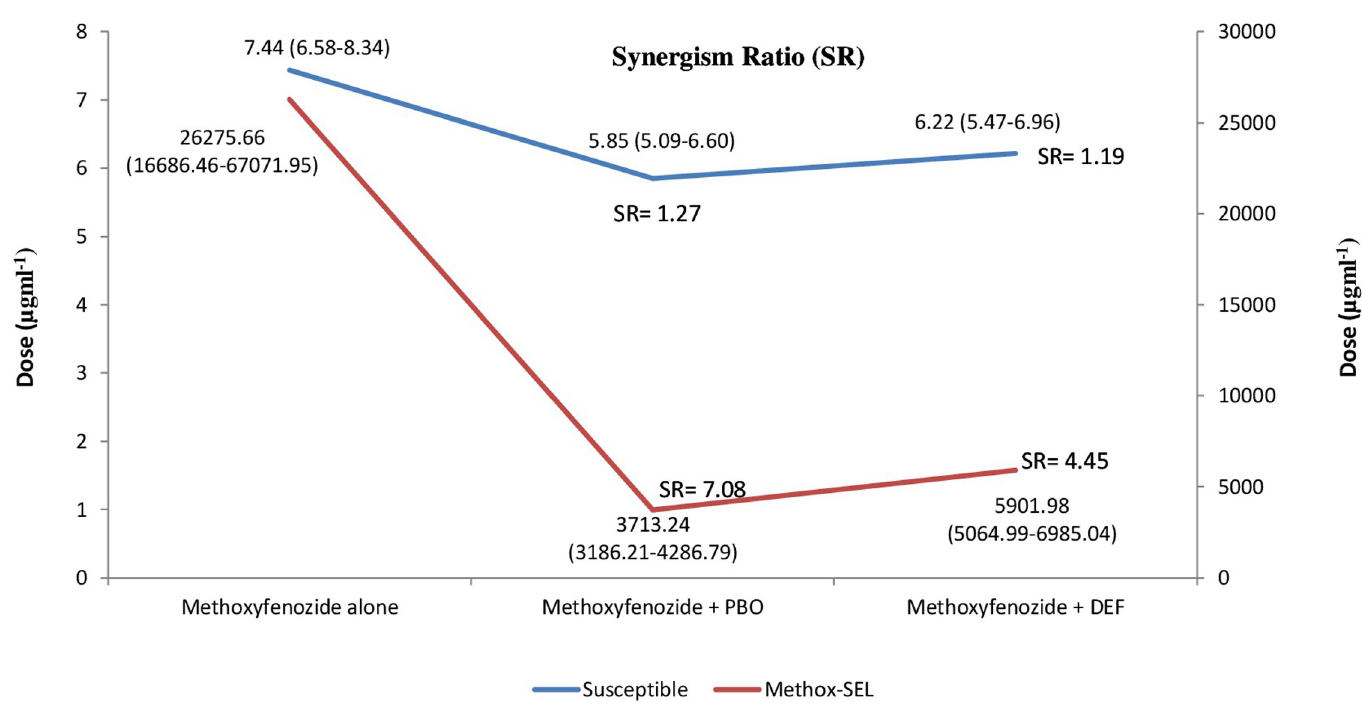
Fig 6. Toxicity of methoxyfenozide alone and with PBO or DEF to the susceptible and Methox-SEL Chrysoperla carnea strains.